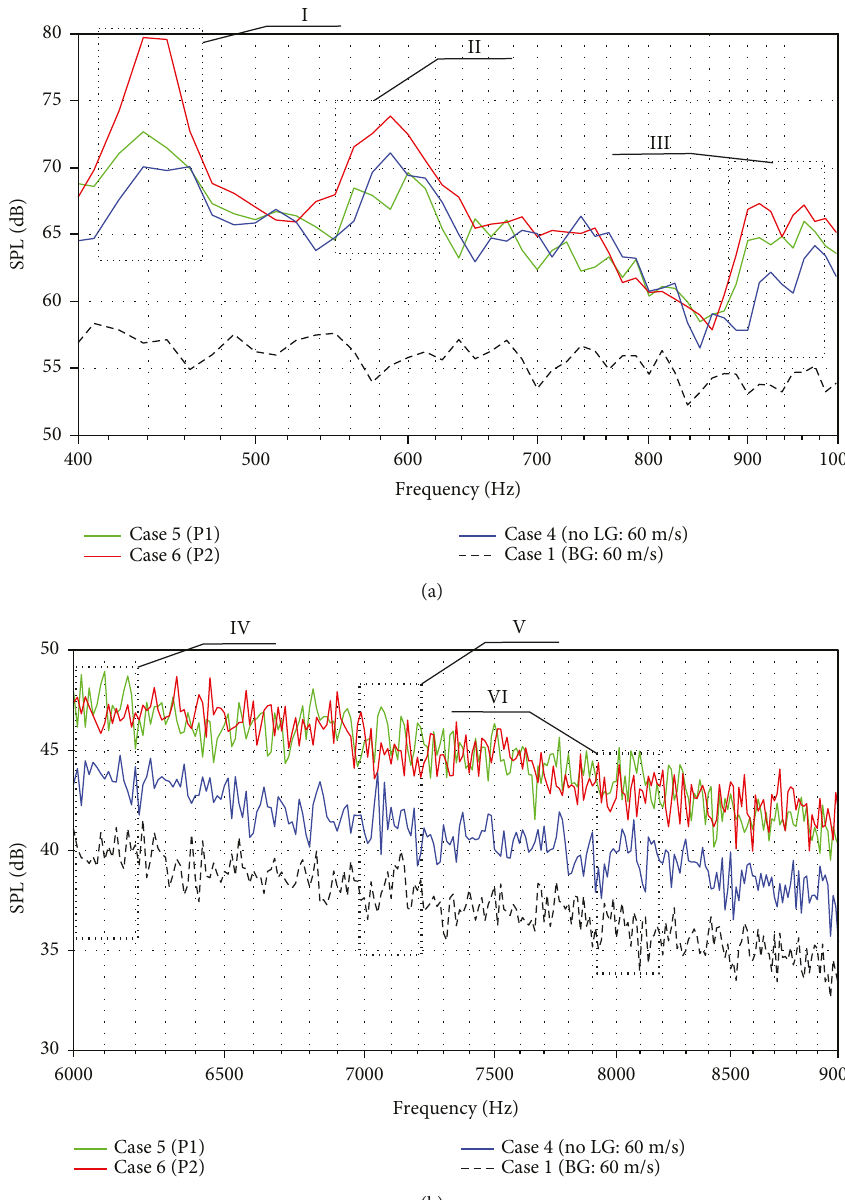
Figure 13: Narrowband A-weighted spectra in di ff erent frequency ranges: (a) 400Hz-1000 Hz; (b) 6000-9000